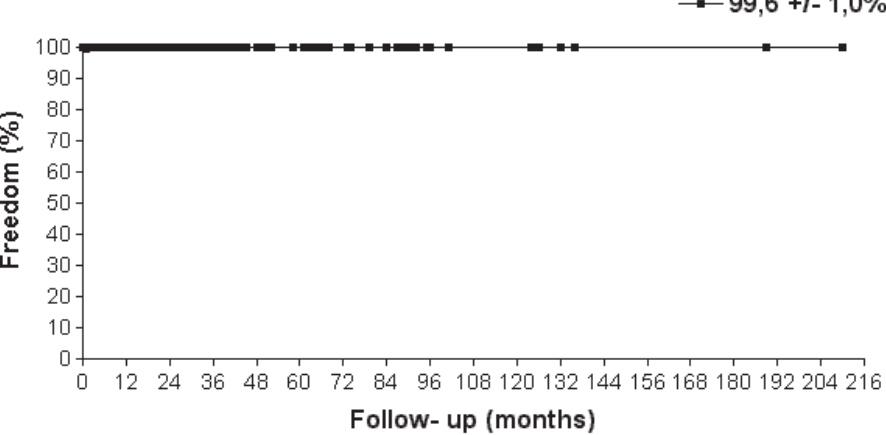
Figure 5 - Actuarial freedom from hemolysis (% +/- Standard